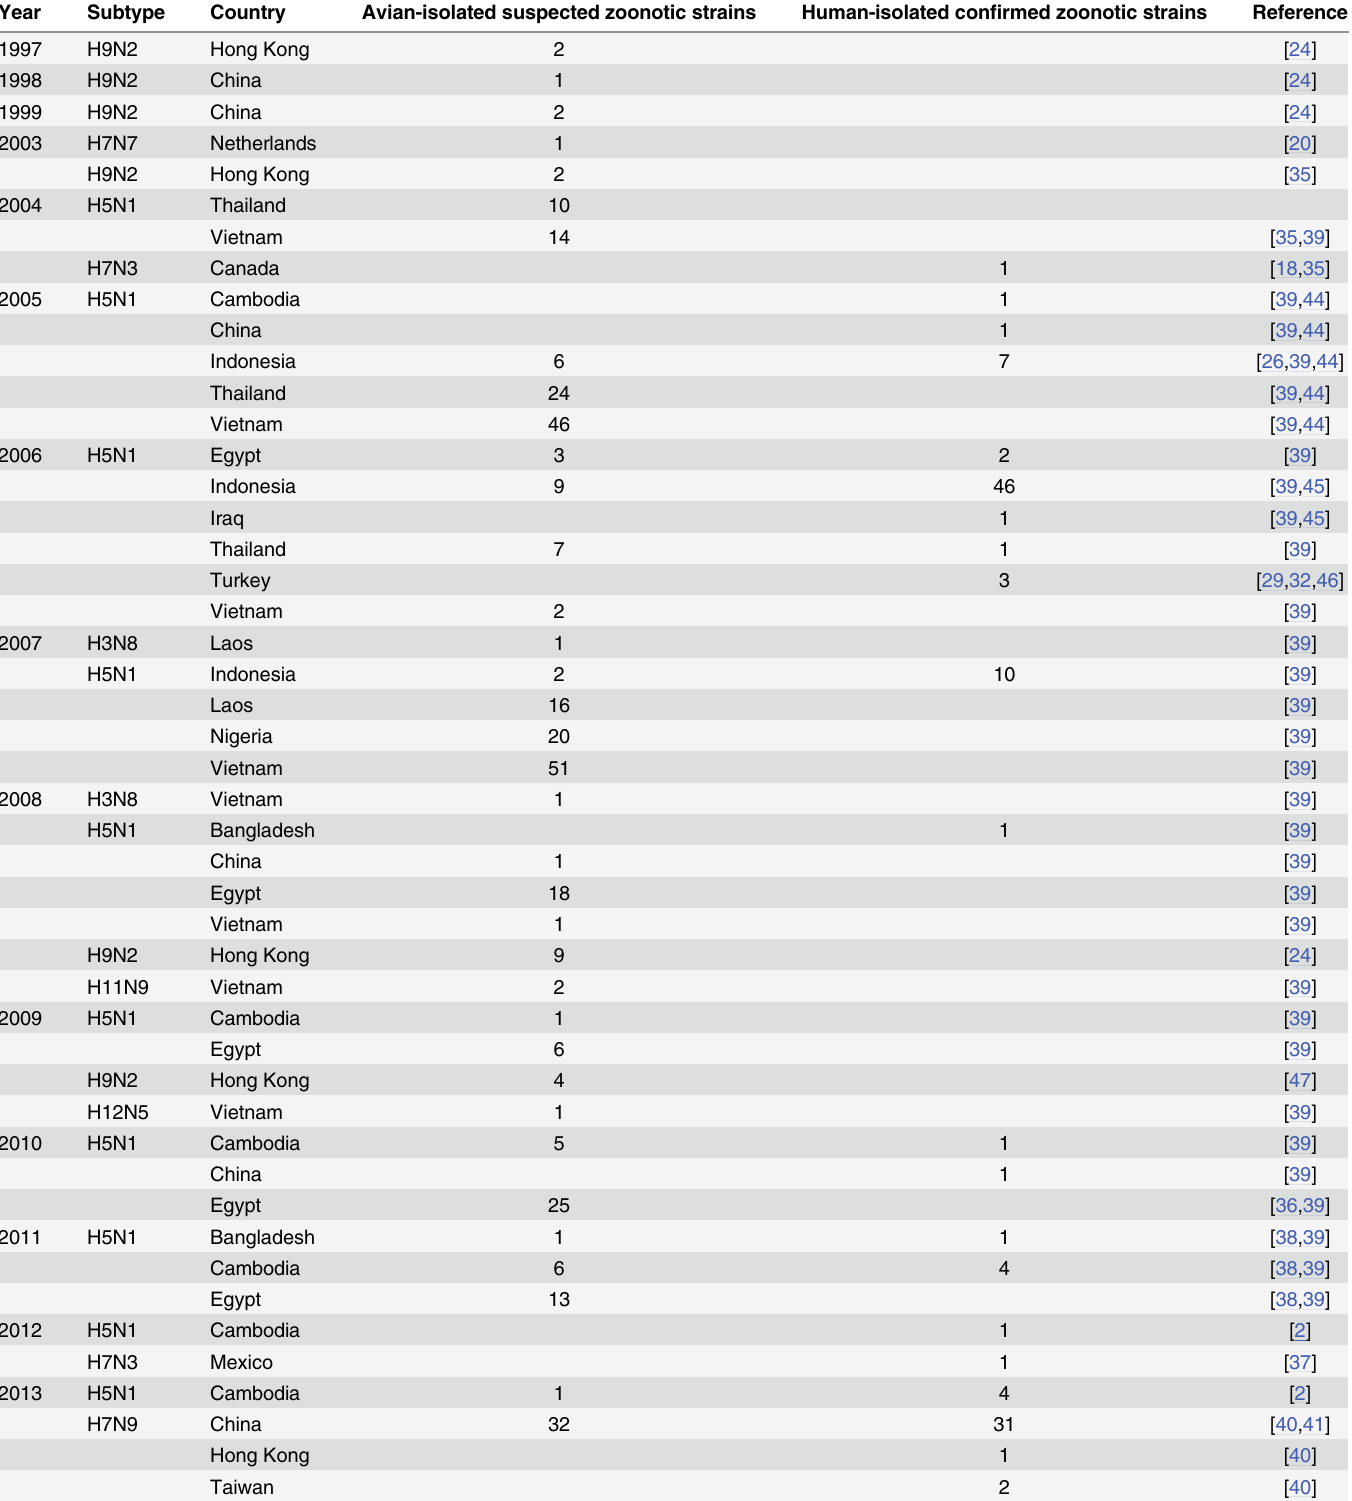
Table 1. Summary of confirmed and suspected zoonotic strains with complete proteome